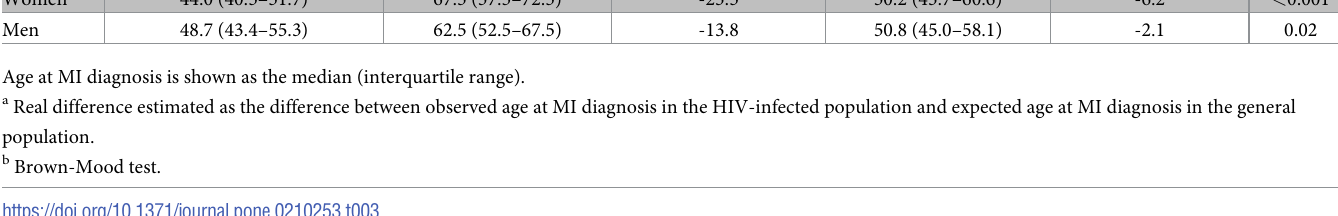
The median ages at MI diagnosis were respectively 48.7 and 44.0 years among men and women living with HIV. After adjustment for age differences, age at MI diagnosis remained significantly younger among both men and women living with HIV (p < 0.05). By comparison with the general population, women living with HIV were diagnosed with MI at a much youn- ger age than women from the general population, while the difference was much smaller for men, with respective median differences of -6.2 years and -2.1 years (Table 3). Table 3. Age at diagnosis of myocardial infarction (MI) among HIV-infected individuals and the general population in France between 2000 and 2009. MI Observed age, HIV-infected population Men Age at MI diagnosis is shown as the median (interquartile range). a Real difference estimated as the difference between observed age at MI diagnosis in the HIV-infected population and expected age at MI diagnosis in the general population. b Brown-Mood